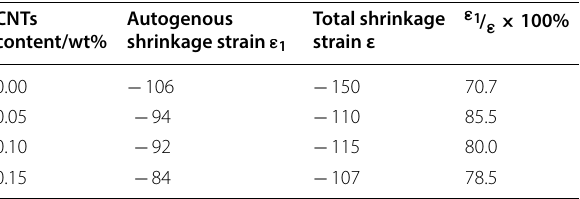
Table 9 Autogenous shrinkage strain and total shrinkage strain of cement mortar with different CNTs dosage (W/C 0.30). =